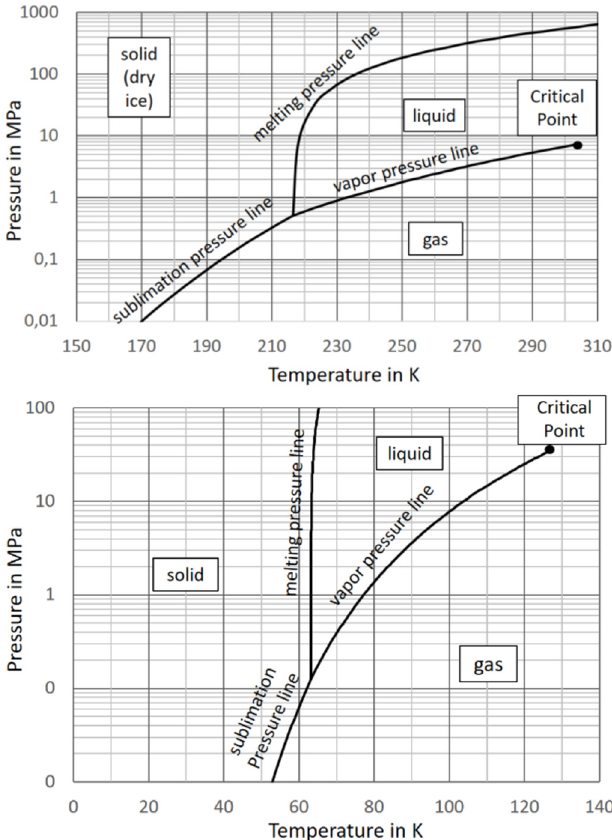
Fig. 3. p – T diagram for CO 2 (upper) and N 2 (bottom), according to [4,5].